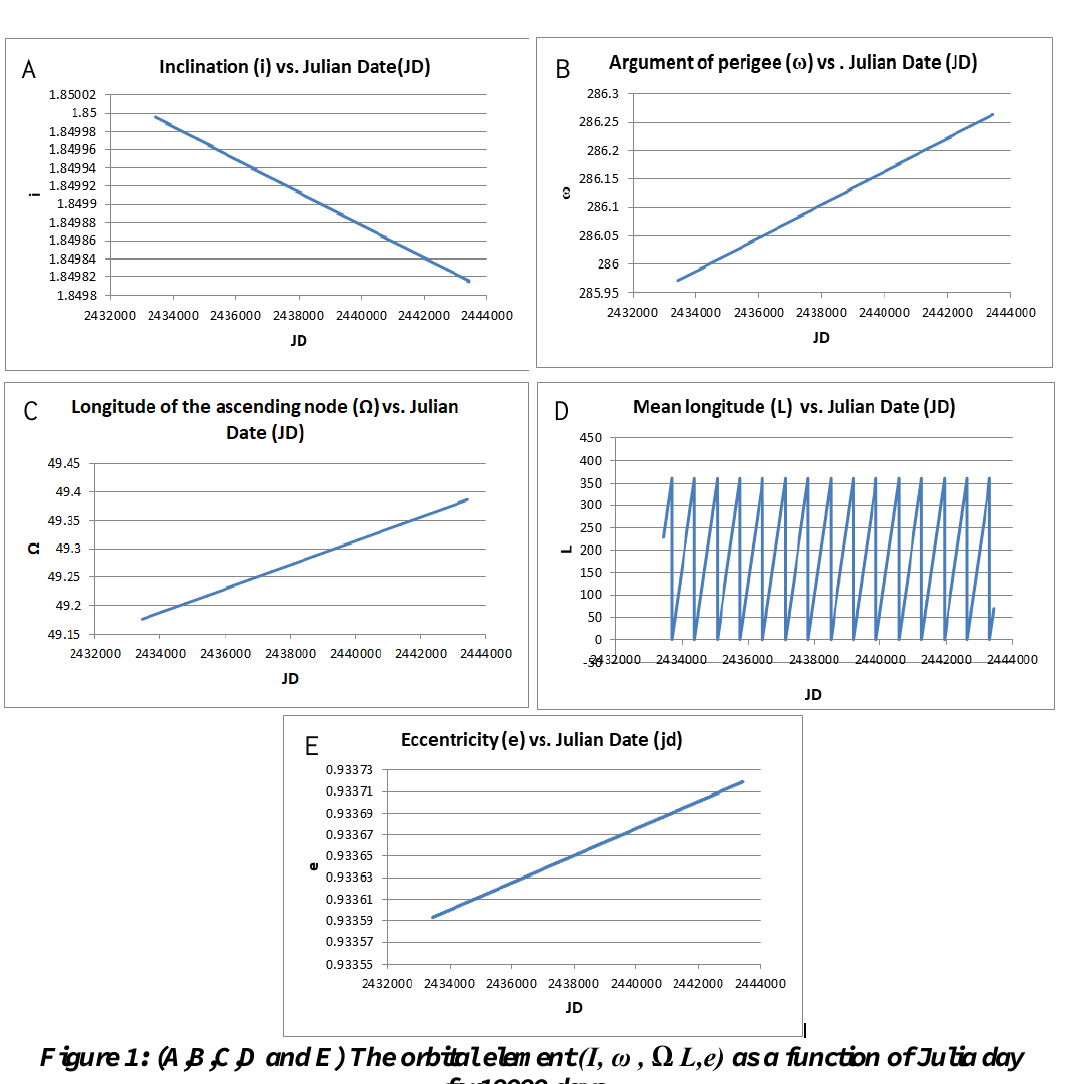
Figure 1: (A,B,C,D and E) The orbital element (I, ω , Ω L,e) as a function of Julia day for10000 days .